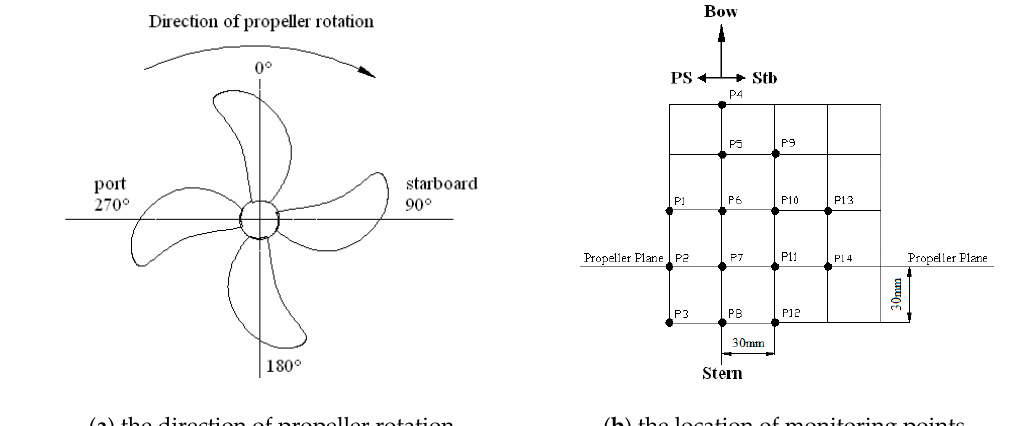
Figure 9. The arrangement of monitoring points.